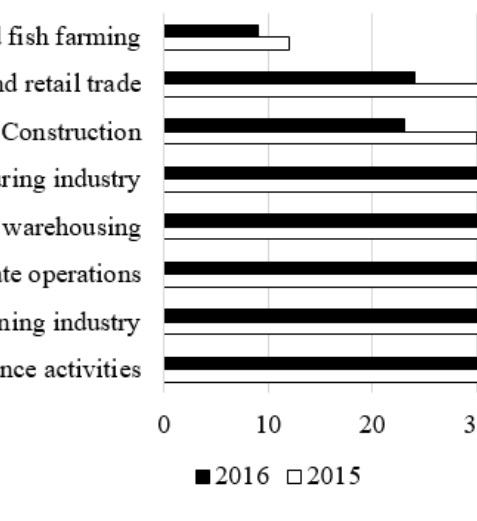
Figure 1. The level of shadow economy by fields of activity, %